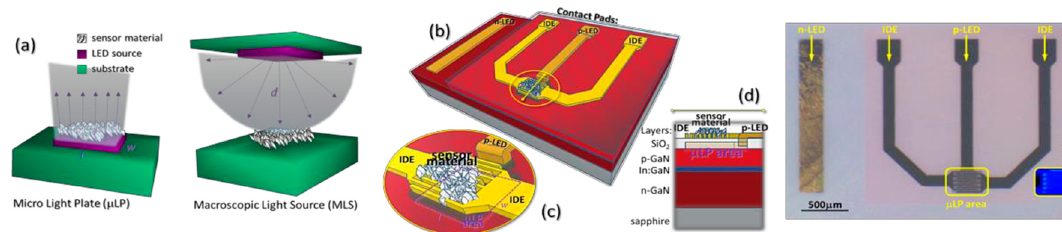
Figure 1. ( a ) Comparison between the Micro Light Plate (µLP) proposed in this work and the conventional light spreading scenario (Macroscopic Light Source). ( b ) Schematic view of the µLP devices. ( c ) Detailed view of the µLP area containing the active LED region, the IDEs, and the sensor material. ( d ) Cross section of the device structure across the µLP area. ( a – d ) Adapted from Ref. [2], with the permission of AIP Publishing. ( e ) Optical microscopy image of the actual µLP devices as fabricated, and ( f ) with the LED lit on.